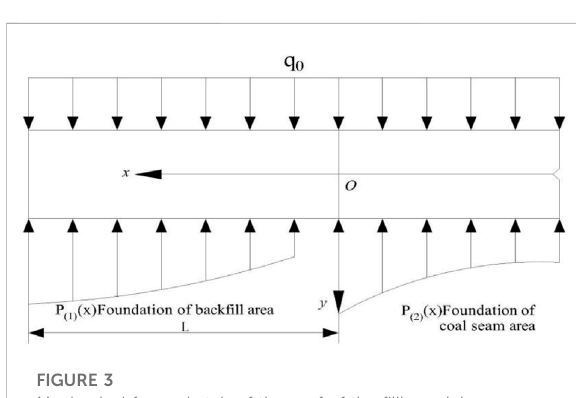
FIGURE 2 Mechanical model of slicing paste fi lling mining structure in thick coal seam.